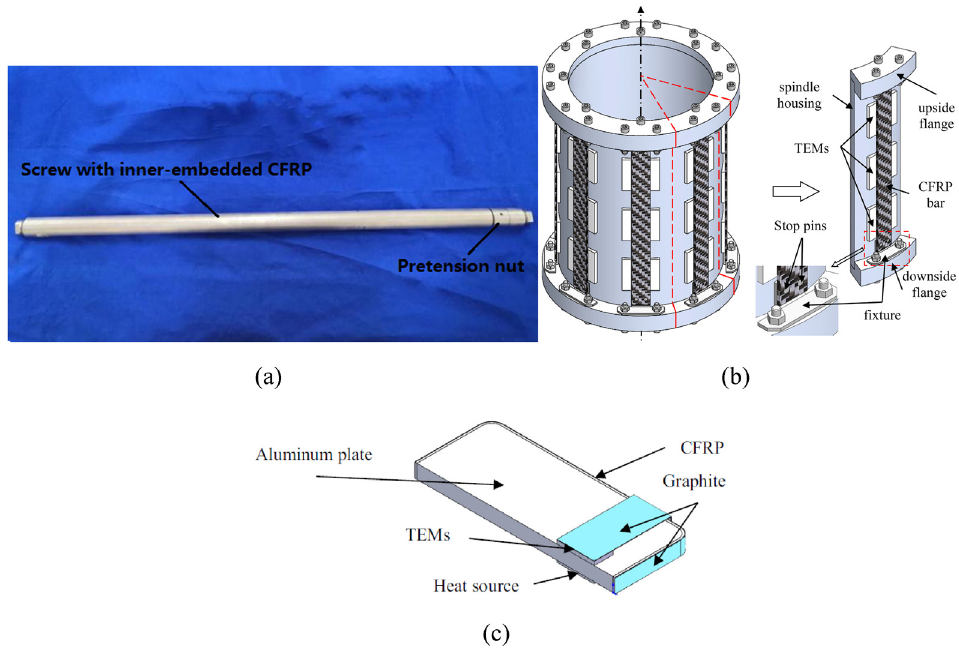
Figure 12: Potential application of the proposed research: ( a ) simpli fi ed ball screw based on inner - embedded CFRP; ( b ) spindle housing with CFRP [ 22 ] ; ( c ) rectangular structure in machine tool with CFRP [ 23 ]